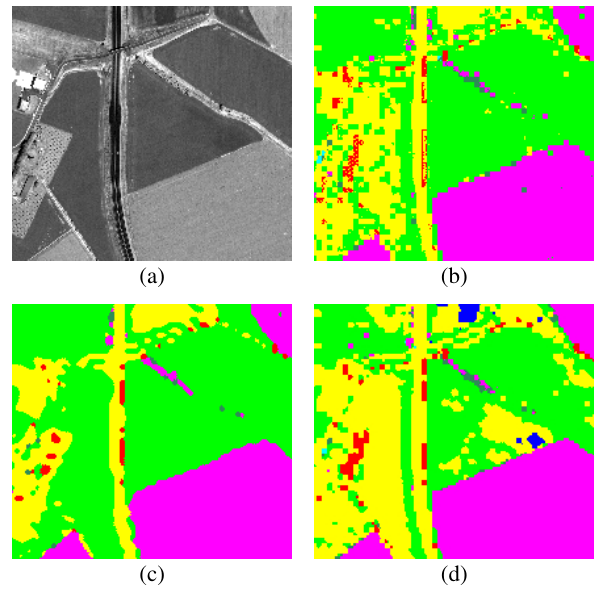
Figure 6. “Alessandria” data set. Details of (a) the IKONOS panchromatic image at 1 -m resolution and of the classification maps obtained using (b) a single-resolution MRF after resampling, (c) the method in (Moser et al., 2016), and (d) the proposed algorithm. Class legend: urban, agricultural, rangeland, bare soil, forest, water, wet